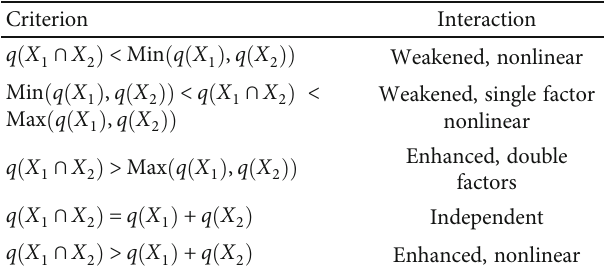
Table 3: Types of interaction between two